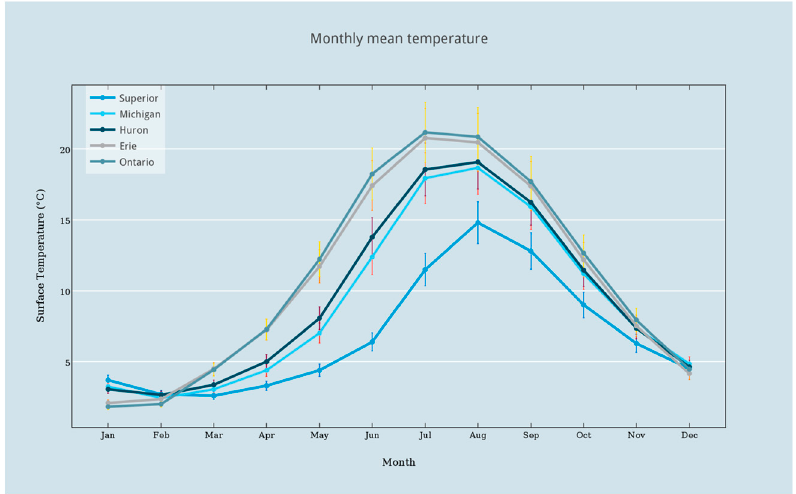
Figure 3. Monthly mean GLST computed from July 2001 to December 2014; vertical bars represent one standard deviation.